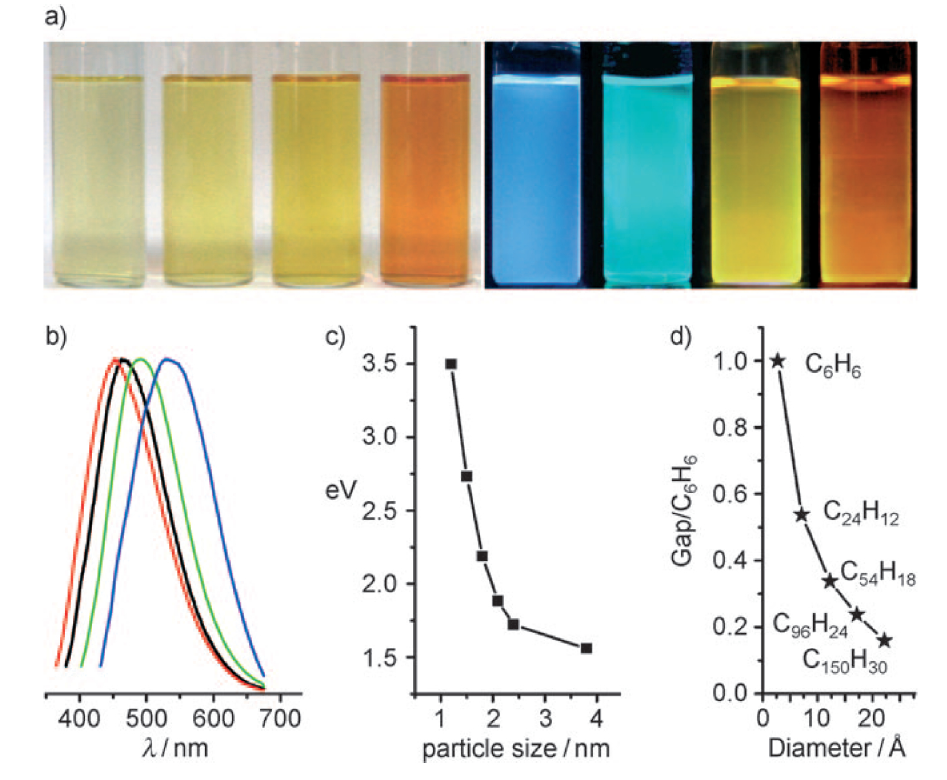
Figure 6. ( a ) solutions of CDs with different sizes under daylight (left) and UV light (right; 365 nm); ( b ) emission spectra of different fractions: the red, black, green, and blue lines are the emission spectra for blue-, green-, yellow-, and red-emitting CDs appearing in panel ( a ), respectively. ( c ) CDs size vs. the emission peak; ( d ) Electronic gap dependence on the size of the graphite fragments, as obtained by quantum chemical calculations. Reproduced with permission from [62]. Copyright John Wiley and Sons,